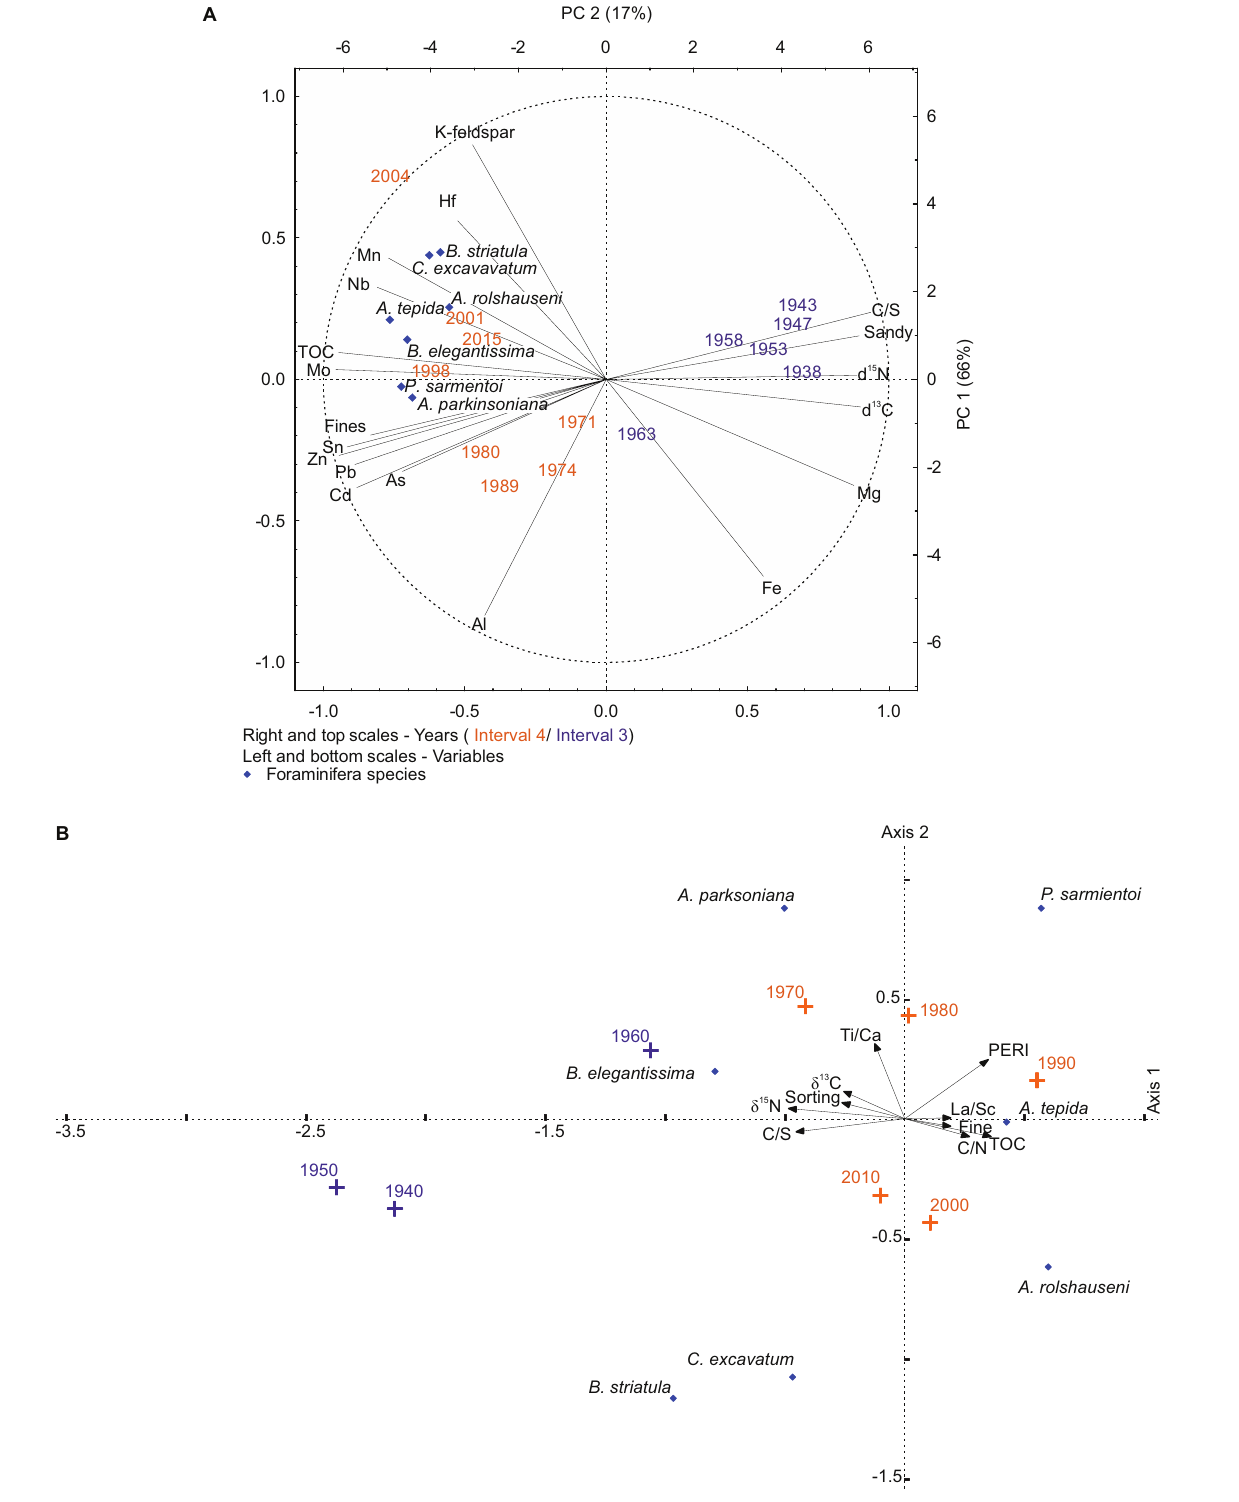
FIGURE 7 | (A) PCA ordination diagram plotting the primary (sediment parameters) and secondary (foraminiferal species) variables as well as layers (years). (B) Canonical correspondence analysis (CCA) showing the relationship among the species, selected sedimentological variables, and samples represented by decades. PERI, potential ecological risk index; Fine, fine